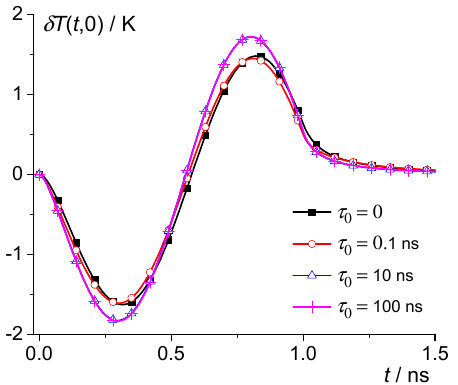
Figure 1. Dependence of the temperature change 𝛿𝑇(𝑡,0) on time for the silicate glass Na 2 O · 2CaO · 3SiO 2 at ∆ T = 200 K; τ 0 = 0, 0.1 ns, 10 ns, and 100 ns—squares, circles, triangles, and crosses.